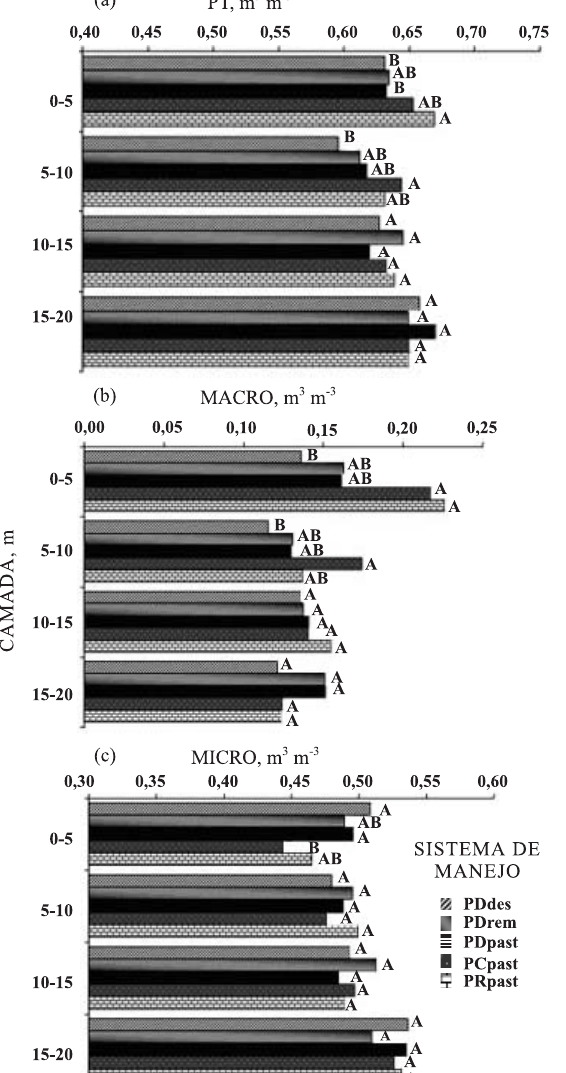
Figura 5. Porosidade total (a), macroporosidade (b) e microporosidade (c) nos sistemas de manejo e camadas, na integração agricultura-pecuária. Média de três épocas: 16, 88 e 190 DAS. Otacílio Costa - SC, 2003/2004. As médias dos sistemas de manejo em cada camada seguidas por letras iguais não diferem a 5 % pelo teste de Tukey.